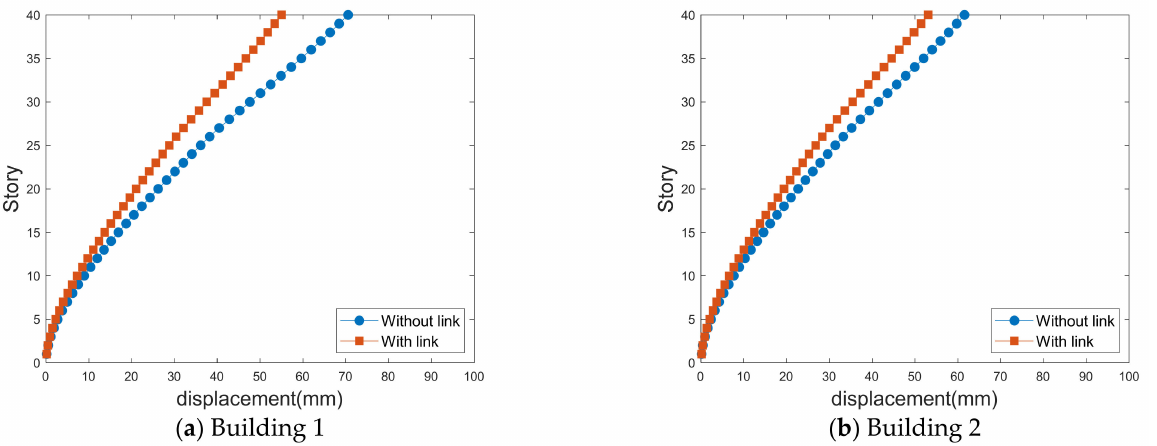
Figure 14. Along-wind-induced lateral displacements with a large gap distance.